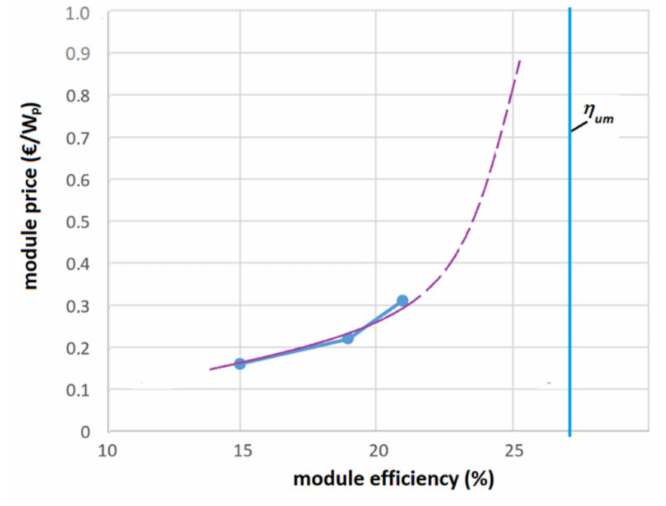
Figure 6. A schematic projection of module price by (7) in comparison with data